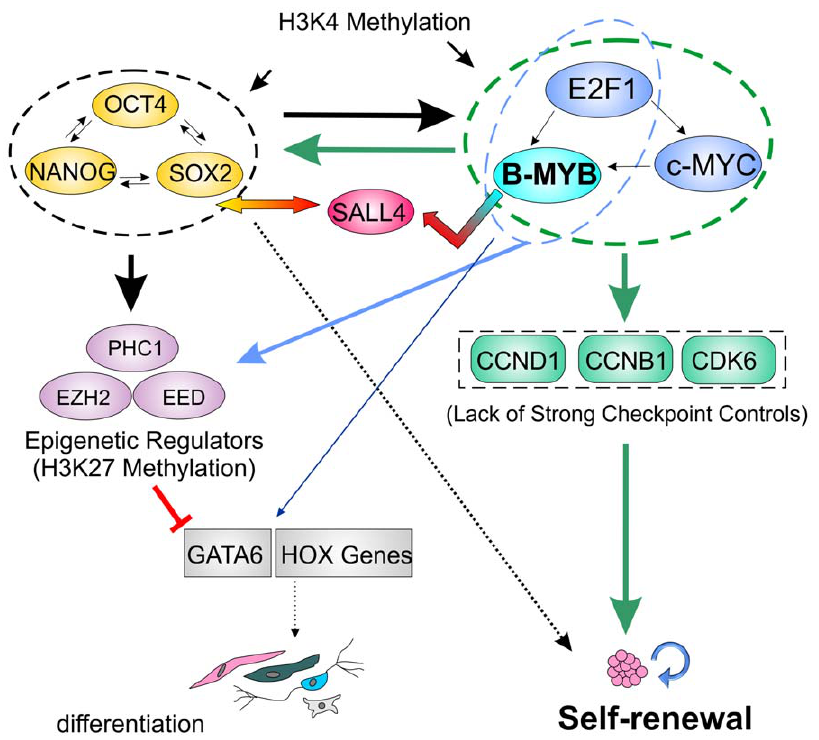
Figure 8. Model depicting transcriptional interactions between pluripotency factors and cell cycle regulators in the maintenance and control of fate decisions that regulate choices between self-renewal and differentiation. In the undifferentiated state, B-MYB promotes high level expression of cell cycle modulators (Green rectangles), pluripotency factors (Yellow ovals) and epigenetic regulators (Purple ovals) to maintain self-renewal; however, upon loss of B-MYB, the subsequent reduction in these factors promotes fate choices that foster differentiation and loss of self-renewal processes. Arrows indicated transcriptional control mechanisms involving epigenetic regulation and/or transcription factor binding, including the postulated indirect effects of B-MYB mediated by SALL4. Colored arrows reflect the transcriptional control of those genes highlighted within ovals (Blue – B-MYB, E2F1; Green – B-MYB, c-MYC, E2F1; Black – Oct4, SOX2, Nanog). GATA6 and HOX genes (Grey rectangles) bind B-MYB, but are transcriptionally inactive unless differentiation is